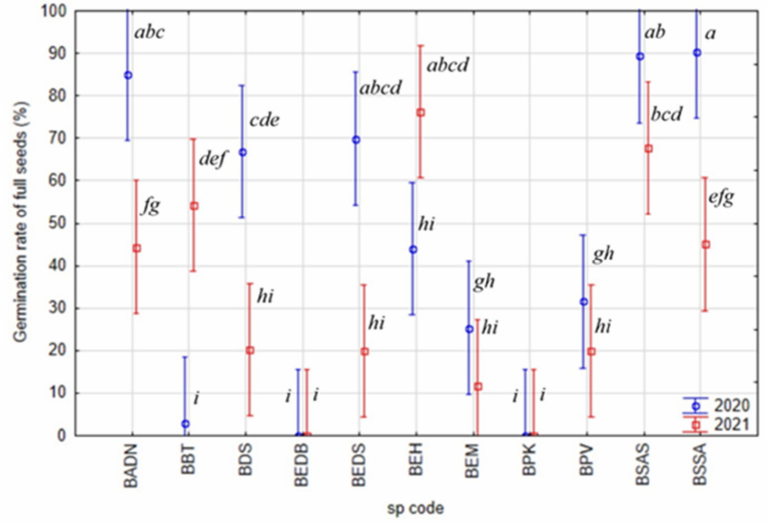
Figure 7. Inter-annual variability of germination rate of full seeds of tested Boswellia species (a, b, c, d, e, f, g, h, i—Indexes denoting localities with significantly separate germination rates within individual taxon, the same index associates the seed without statistically significant difference in germination energy of full